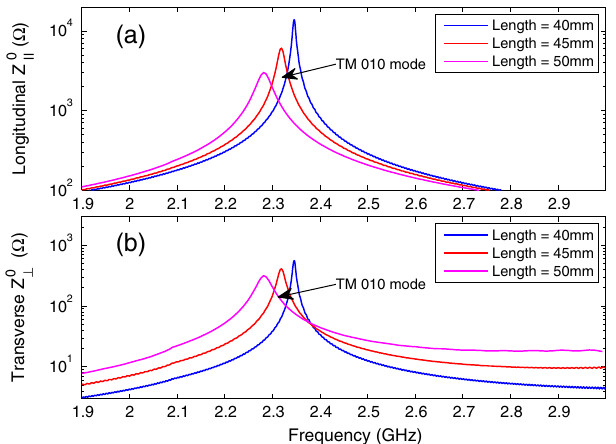
FIG. 7. The longitudinal wake W 0 ∥ spectrum (a) and transverse wake W 0 ⊥ spectrum (b) with different on-cell opening length L . We can clearly see the peaks of TM 010 -like mode.